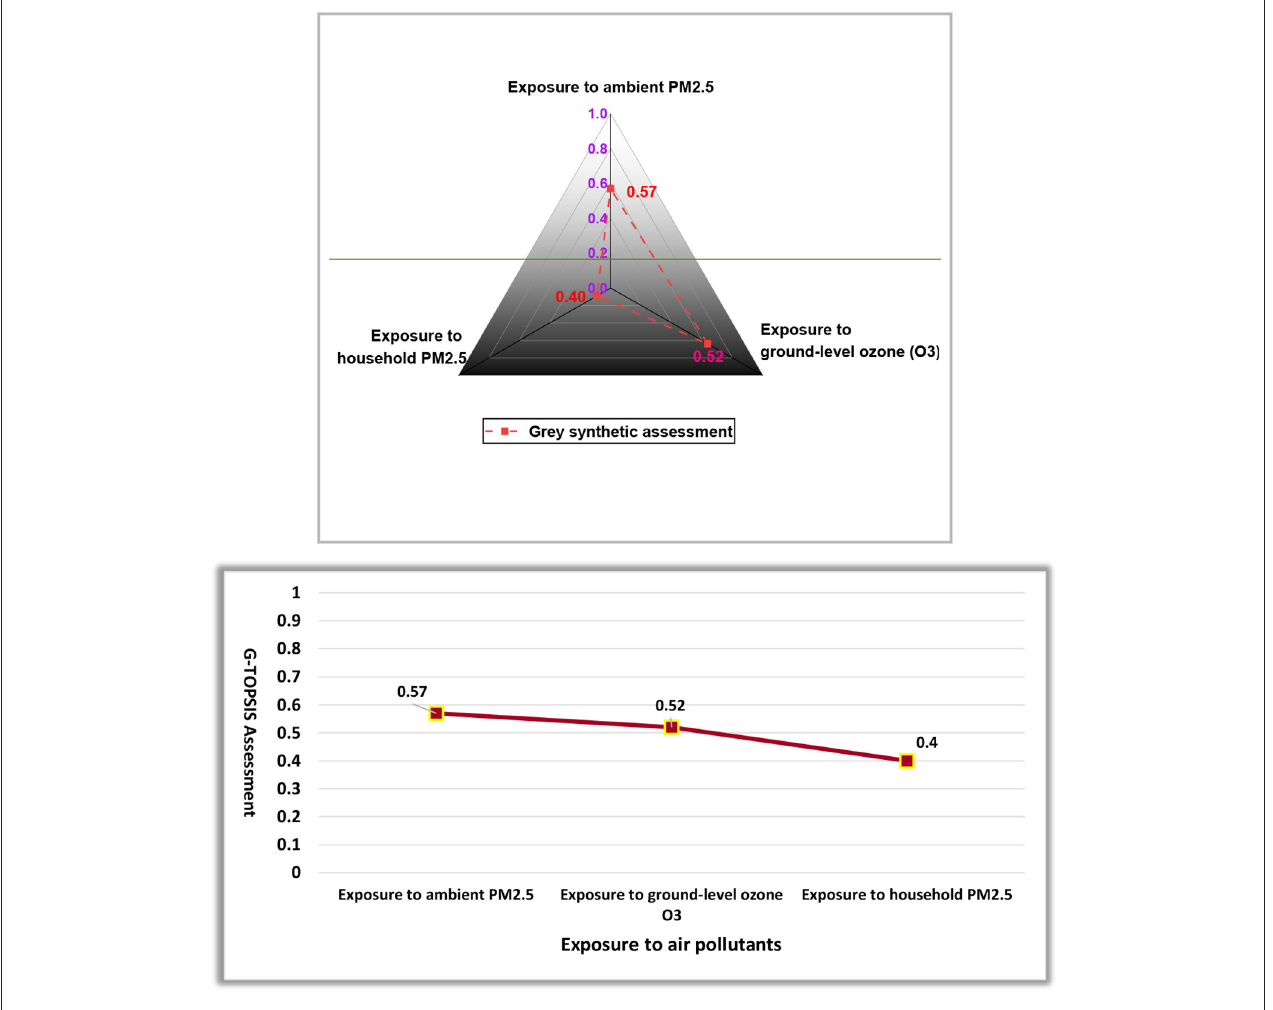
FIGURE 5 | Grey-based Technique for Order of Preference by Similarity to Ideal Solution (G-TOPSIS) assessment of IHD-related risk